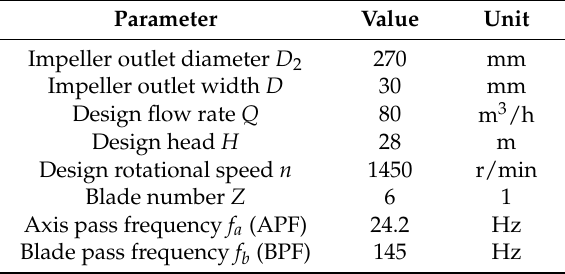
Table 1. Geometric and performance parameters used for a simulated centrifugal pump (water).